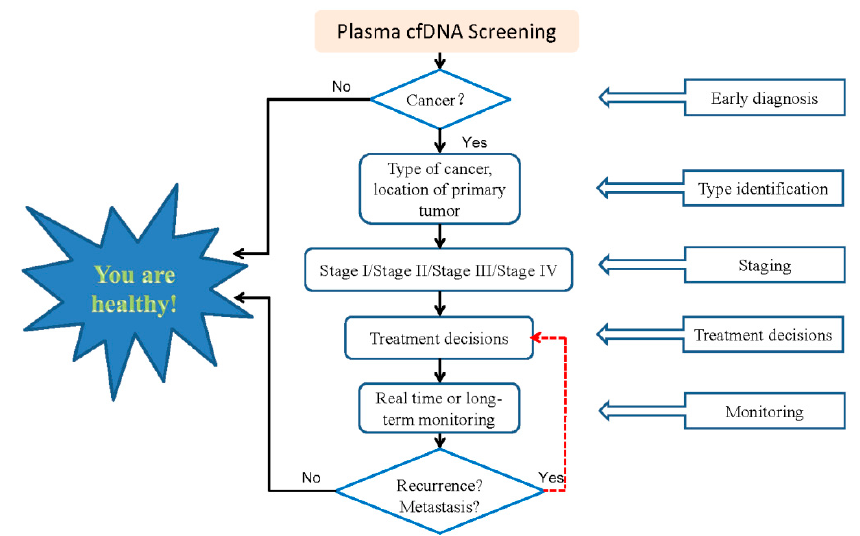
Figure 2. The workflow of cfDNA tests in clinical diagnosis, treatment and prognosis for